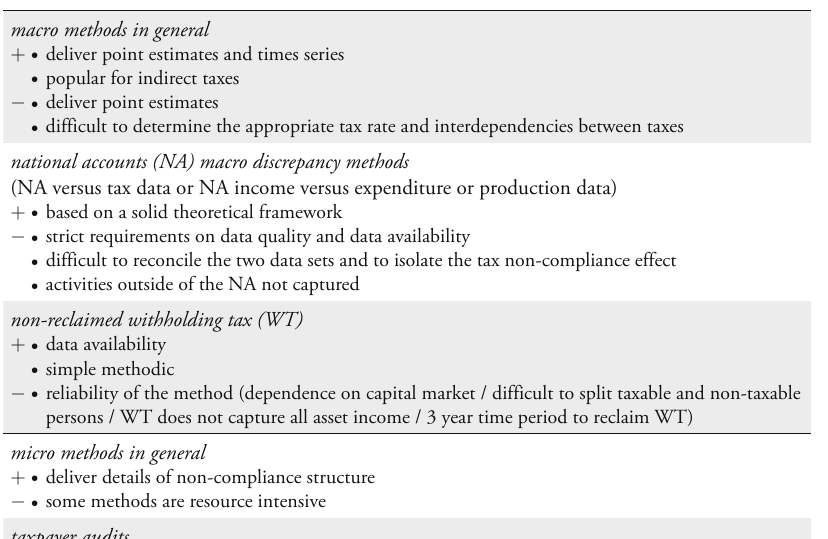
Table 2: Measurement